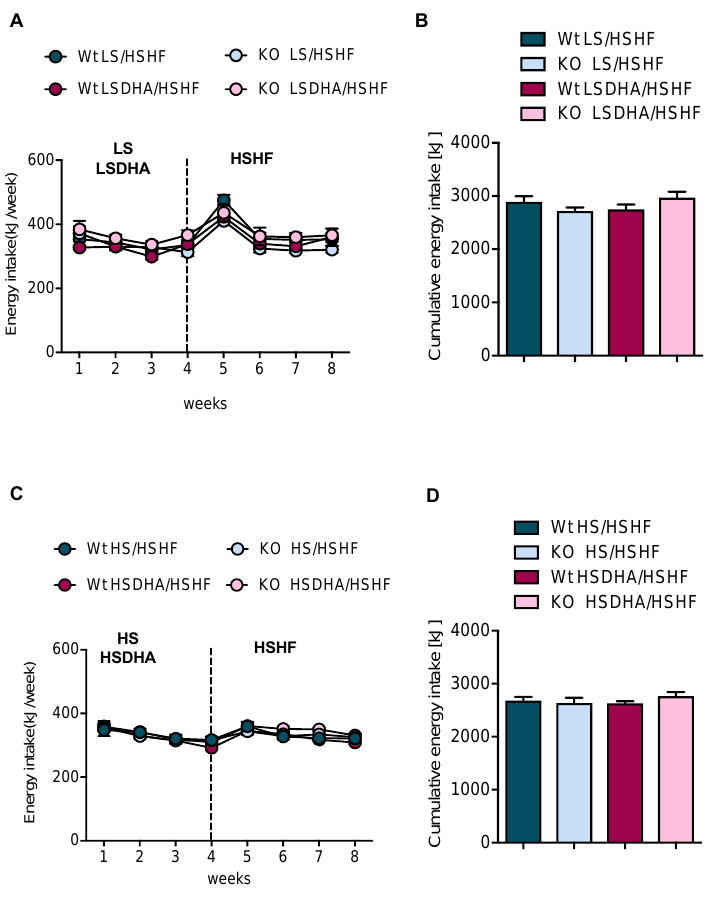
Figure 3. DHA supplementation and sucrose content do not a ff ect energy intake. ( A ) Weekly energy consumption of wild-type and Elovl2 - / - mice fed low-sucrose diet (LS) or low-sucrose DHA-enriched diet (LSDHA), followed by high-sucrose, high-fat diet (SHF). ( B ) Cumulative energy intake, presented as kJ intake per eight weeks, for wild-type and Elovl2- / - mice fed low-sucrose diet (LS) or low-sucrose DHA-enriched diet (LSDHA) followed by high-sucrose, high-fat diet (HSHF). ( C ) Weekly consumption of animals fed high-sucrose (HS) or high-sucrose DHA-enriched diet (HSDHA), followed by high-sucrose, high-fat diet (HSHF). ( D ) Cumulative energy intake of animals fed high-sucrose (HS) or high-sucrose DHA-enriched diet (HSDHA) followed by high-sucrose, high-fat diet (HSHF). Results shown are means of 4–9 mice ± SEM.